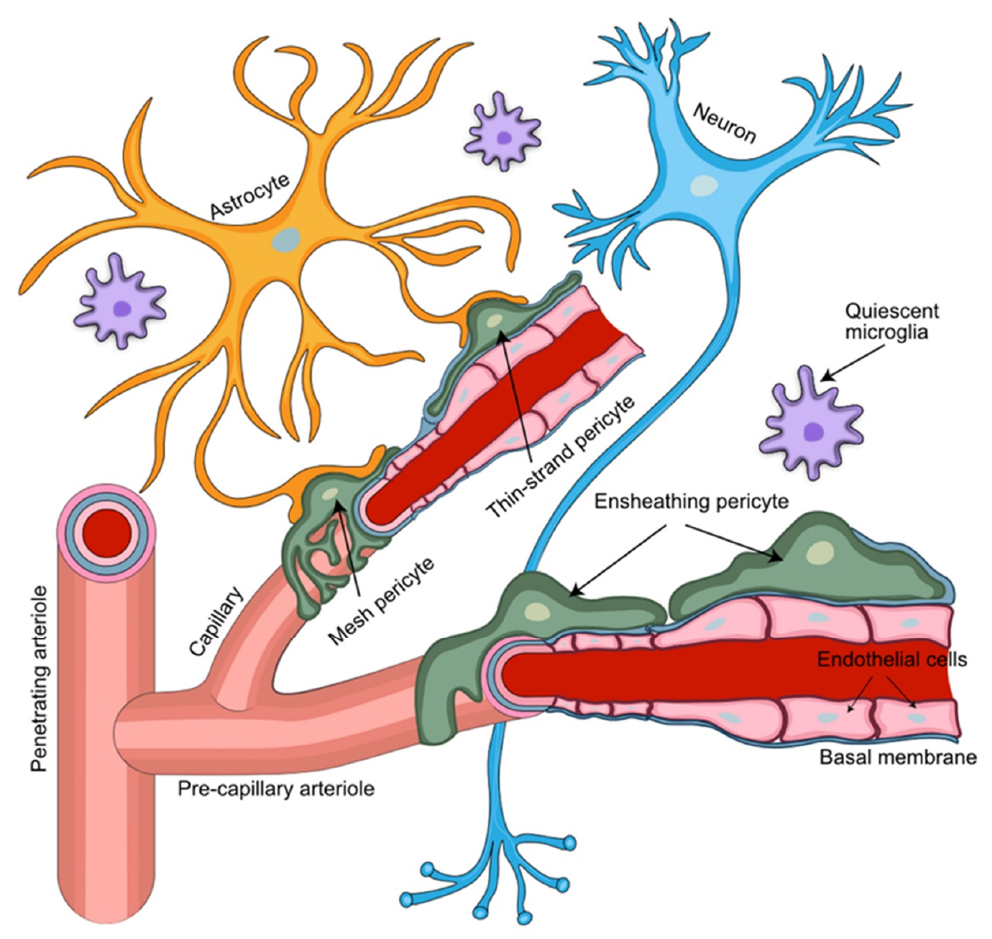
Figure 1. Perivascular arrangement of pericytes among NVU cellular structures . Pericytes extend their ramified processes along the brain vasculature, coming into direct contact with the vascular endothelium and astrocytic end-feet. Pericytes embedded in the capillary basement membrane, together with the endothelial cells of the capillary wall and astrocytic end-feet, form the blood–brain barrier. Different types of pericytes are found in distinct locations of the NVU. Ensheathing pericytes occupy mostly pre-capillary arterioles, while mesh and thin-strand pericytes are found mainly at the capillary portion of the brain microvasculature.